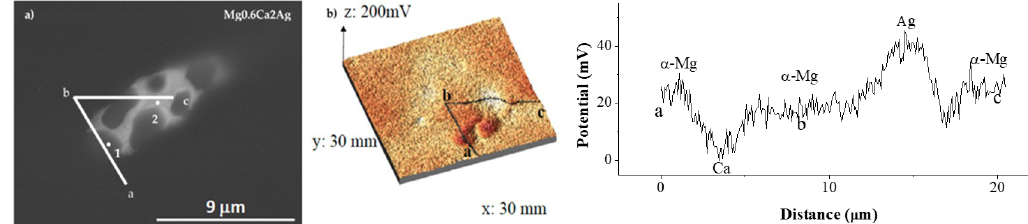
Figure 5. SEM backscattered image ( a ), surface potential maps ( b ) and potential profile ( c ) in selected